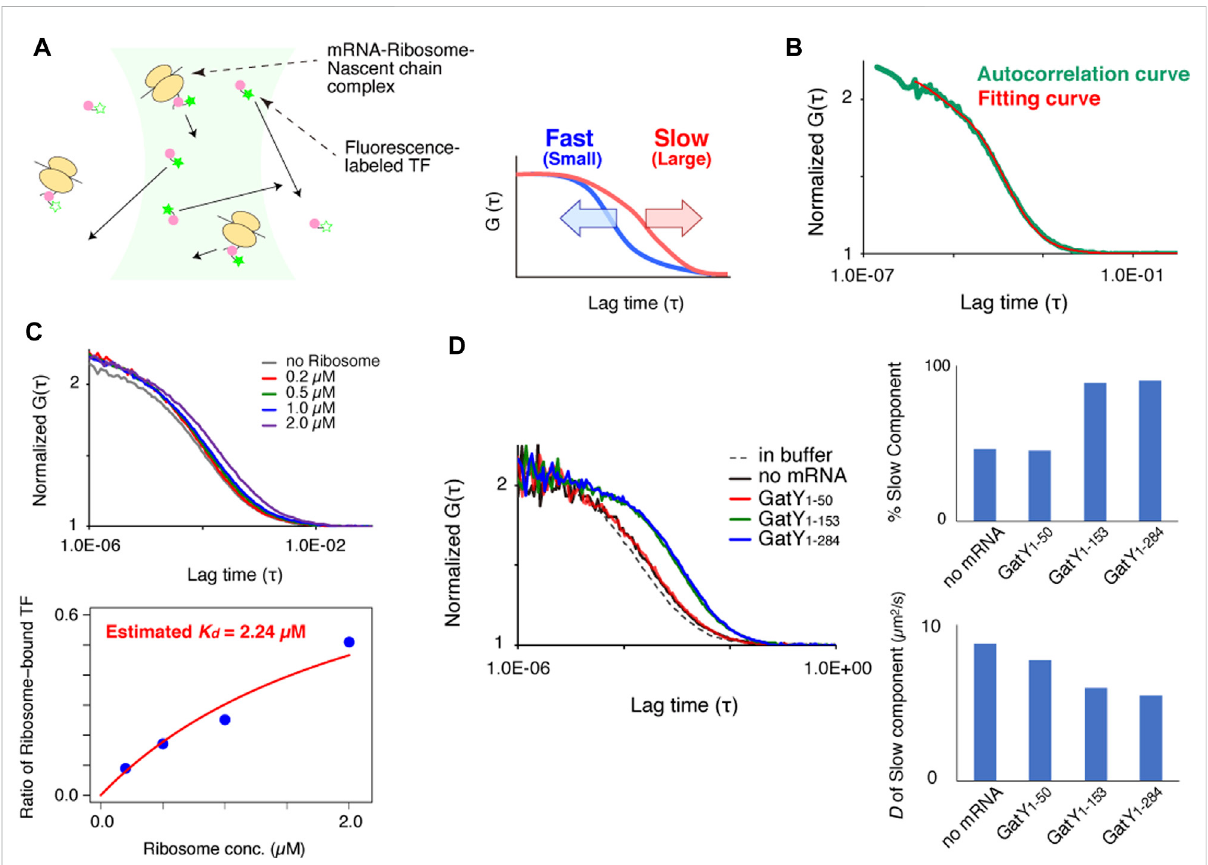
FIGURE 1 FCS measurement system for investigating interactions between trigger factor (TF)and the ribosome-nascentchain complex(RNC) invitro . (A) Schematic illustration of the experimental procedure and the relationship between the autocorrelation curve obtained by FCS measurements and the diffusion time of the fl uorescent molecules. (B) Normalized autocorrelation curve of Alexa488-labeled TF in buffer solution. Red lines indicates the fi tting curve with a one-component model. The concentration of the Alexa488-labeled TF was 100 nM. (C) Investigation of the interaction between Alexa488-labeled TF and vacant ribosomes in buffer solution. The upper panel shows the normalized autocorrelation curves of Alexa488- labeled TF under each condition. The lower panel shows the ratios of ribosome-bound TF under each condition evaluated by a curve fi tting with a two-component model. The dissociation constant ( K d ) was estimated by a fi tting (red curve), shown in the method, as 2.24 µM. (D) Interactions between Alexa488-labeledTFand RNCafter thetranslationreaction.The leftpanel showsnormalizedautocorrelationcurves undereachcondition. The right panel represents the ratio of the slow component (upper panel) and diffusion coef fi cient (lower panel) evaluated by a curve fi tting with a two-component